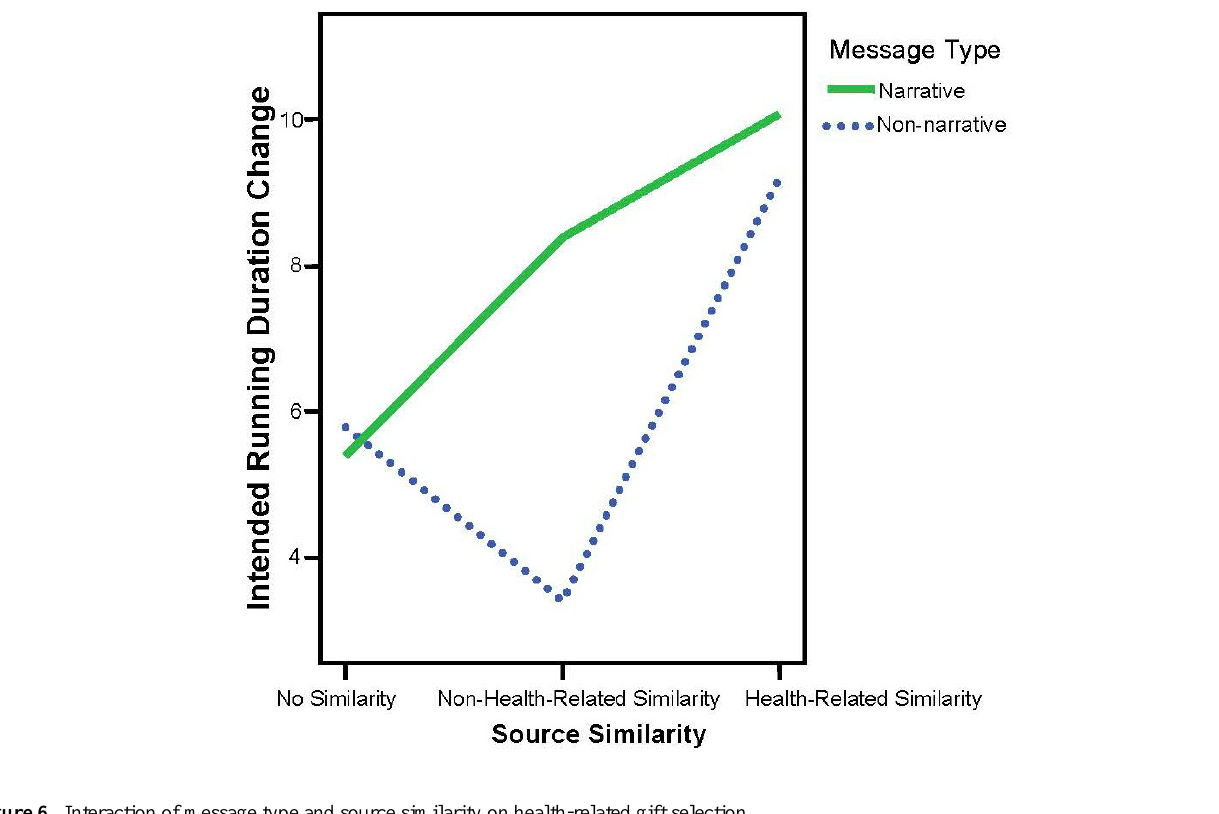
Figure 5. Interaction of message type and source similarity on intended running duration change.